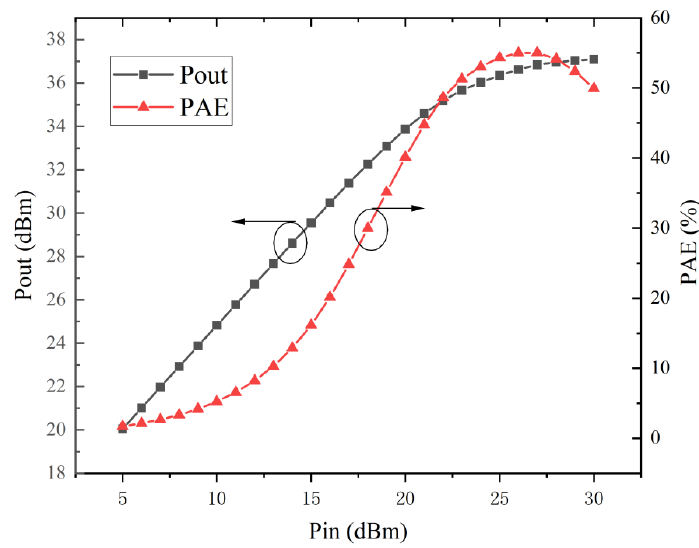
Figure 6. 𝑃 𝑜𝑢𝑡 and PAE of 2 × 4 × 125 µm HEMT under frequency of 12 GHz. Figure 6. P out and PAE of 2 × 4 × 125 µ m HEMT under frequency of 12